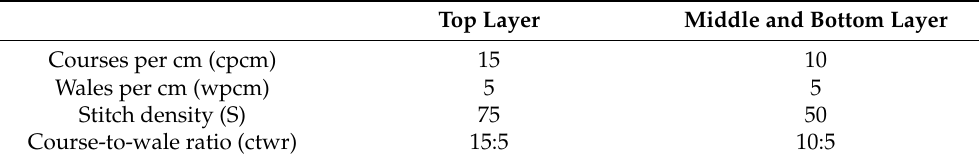
Table 2. Knitted structure parameters of the three actuator layers (common to all actuator types). Top Layer Middle and Bottom Layer